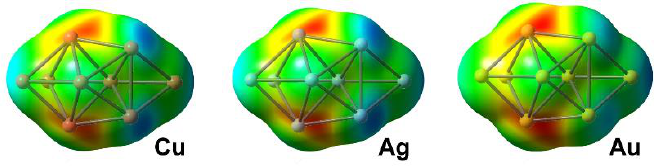
Figure 3. Coinage metal clusters [55].